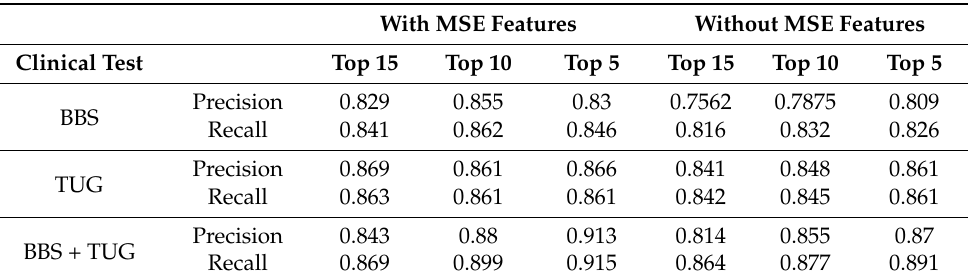
Table 7. Comparing the effect of including or excluding MSE features on the average precision and average recall values for the relevant clinical scores.